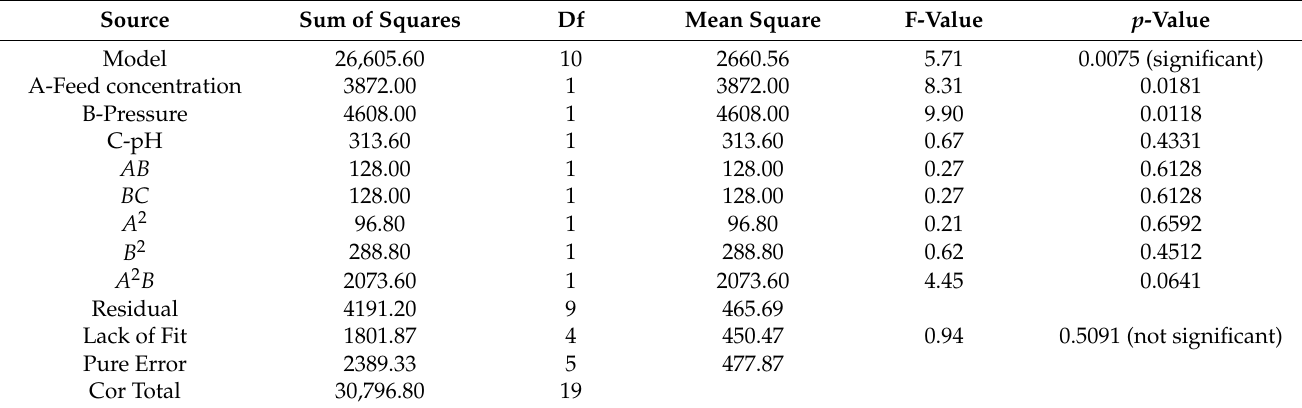
Table 4. Analysis of variance of the developed water flux based on the modified cubic model. Sum of